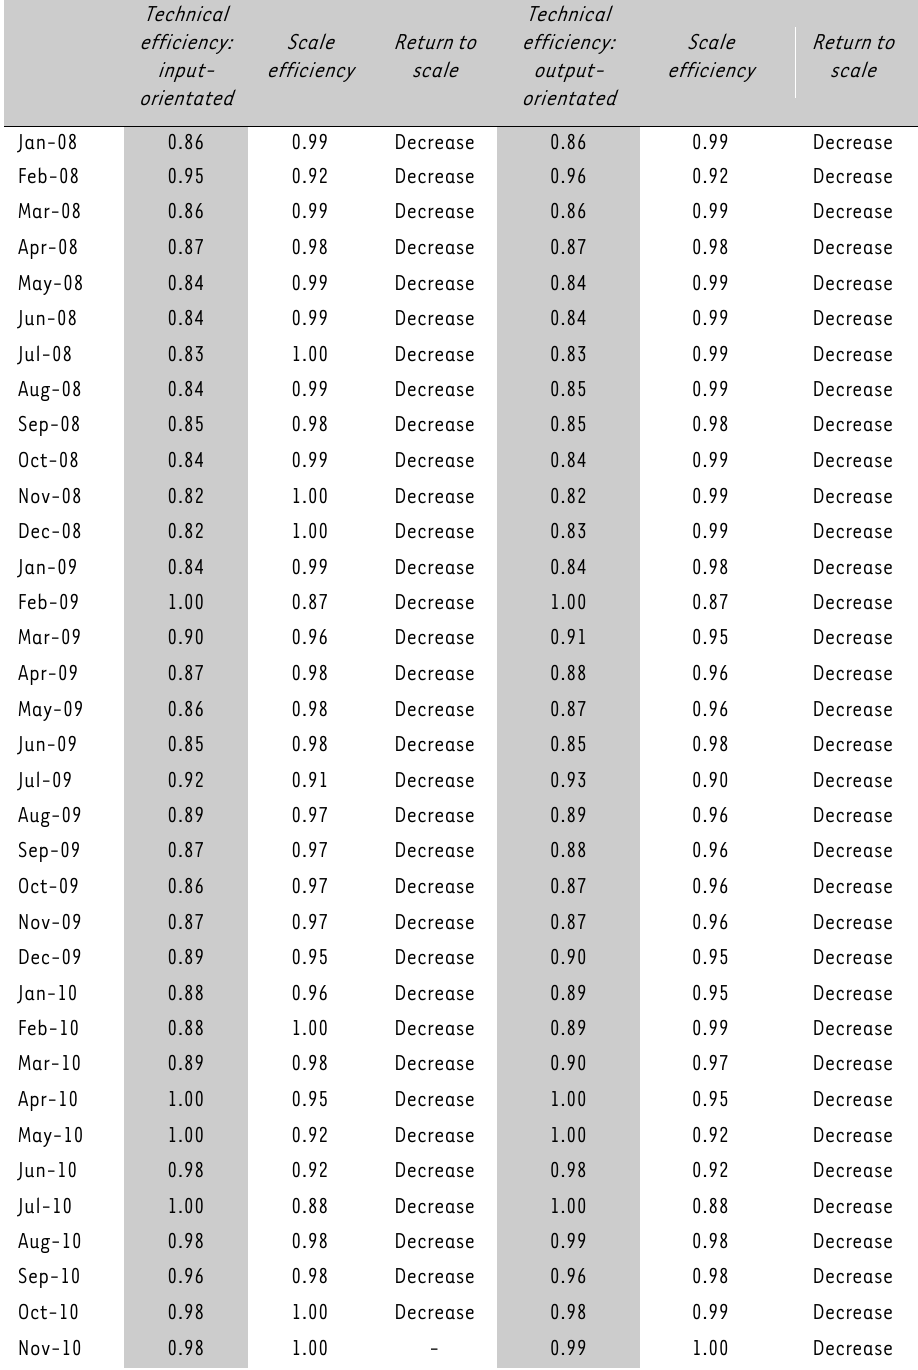
TABLE 16: Efficiency estimates: Nedbank